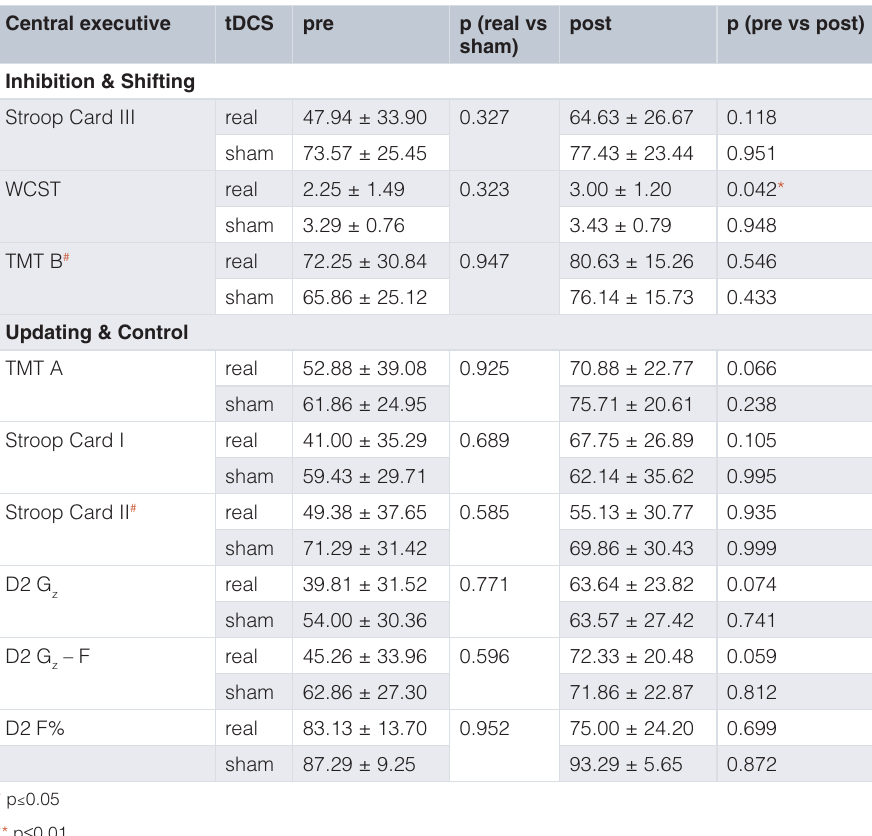
Table 5. Pre- and postscores and p-values of the executive function assessments per group.